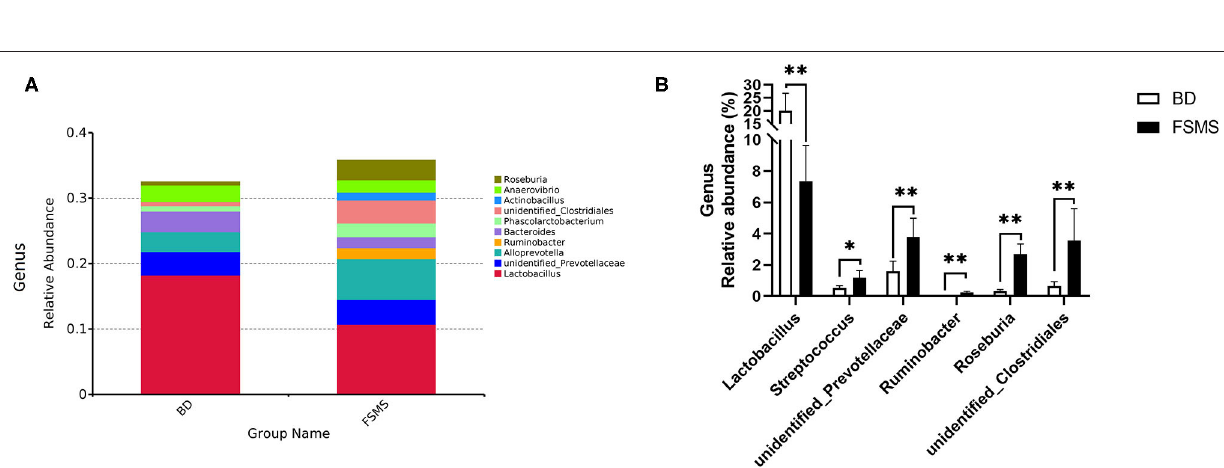
FIGURE 4 | Relative abundance of bacterial genus in the cecal digesta of pigs (A) . Significant changed genera in the cecal digesta (B) . Values were expressed as means ± SEM ( n = 6). Statistical differences were calculated by Duncan: * p < 0.05, ** p < 0.01.